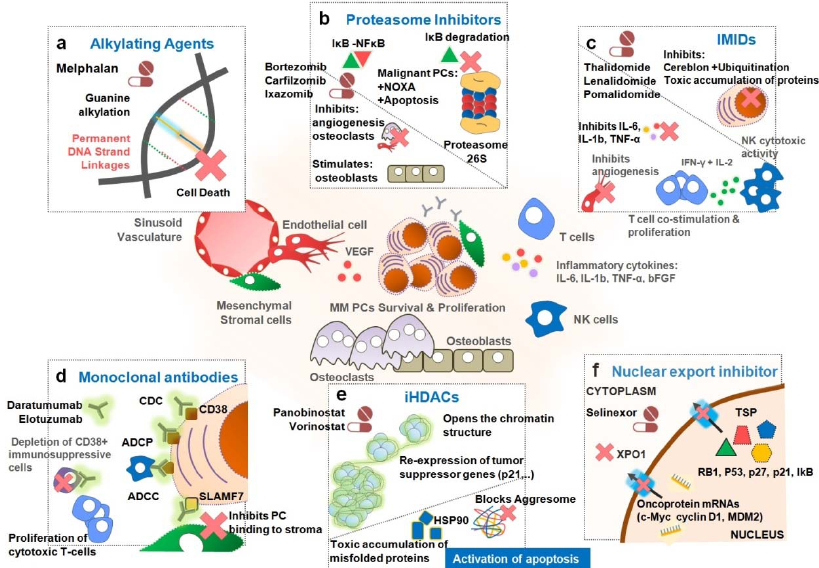
Figure 2. Therapeutic options to counteract MM. Treatments used for symptomatic or active MM include corticosteroids, alkylating agents, proteasome inhibitors (PIs), immunomodulatory drugs (IMIDs), monoclonal antibodies (mAbs), histone deacetylase inhibitors (iHDACs) and nuclear export inhibitors. ( a ) Classical alkylating agents as melphalan target highly proliferating cells, including malignant PCs, by intercalating permanently their DNA, causing cell death later on. ( b ) PIs as bortezomib, carfilzomib and ixazomib block the IkB and/or pro ‐ apoptotic proteins degradation in malignant plasma cells proteosome, overcoming their resistance to apoptotic stimuli. ( c ) IMIDs as thalidomide, lenalidomide and pomalidomide modulate the inflammatory environment of the BM inhibiting the progression of MM [e.g., reduction of Interleukin ‐ 6 (IL ‐ 6), tumor necrosis factor ‐α (TNF ‐α ), etc.] through inhibition of angiogenesis and other key stromal ‐ MM cell interactions). Some of these drugs target the cereblon protein of the E3 ubiquitin ligase complex blocking the ubiquitination process in malignant PCs. This in turn leads to a toxic accumulation of proteins and cell death. ( d ) Monoclonal antibodies (mAbs) as daratumumab, isatuximab and elotuzumab bind to specific antigens on the surface of malignant PCs. This will in turn induce MM plasma cell death by antibody ‐ dependent cell ‐ mediated cytotoxicity (ADCC), complement ‐ dependent cytotoxicity (CDC) and/or antibody ‐ dependent cellular phagocytosis (ADCP). ( e ) histone deacetylase inhibitors (iHDACs) such as panobinostat and vorinostat act on malignant PCs by opening the chromatin structure. Consequently, this will activate the expression of tumor suppressor genes, which were previously silenced by aberrant histone acetylation in malignant PCs. ( f ) Exportin 1 (XP01) inhibitors as selinexor act on malignant PCs by blocking the export tumor suppressor proteins out of the nucleus by the XPO1 pump while retaining many oncoprotein mRNAs within the